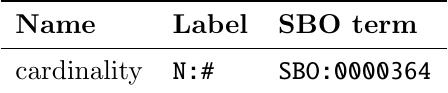
Table 2.6: The format of the possible values for the cardinality unit of information (Sec- tion 2.2.5). Here, # stands for the number; for example, “ N:5